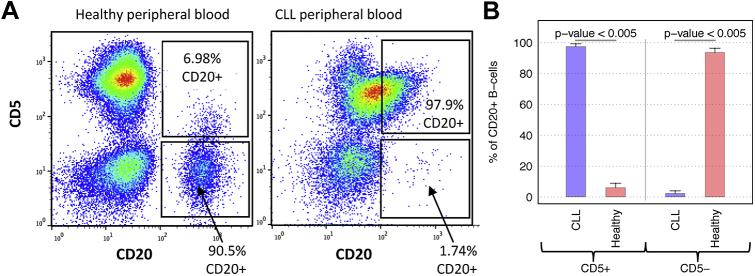
Comparative analysis of CD5high and CD5low B-cell populations in CLL patients and healthy individuals. (A) Peripheral blood mononuclear cell-surface expression of CD5 and CD20. CLL patients showed a higher proportion of CD20+ B cells with high CD5 cell-surface expression compared to healthy individual samples. One representative sample is shown for each. (B) The percentages of CD5high and CD5low B cells (CD20+) in four CLL patients and four healthy individuals, with unpaired t-test p values indicated above sample groups. Error bars indicate mean + SD.